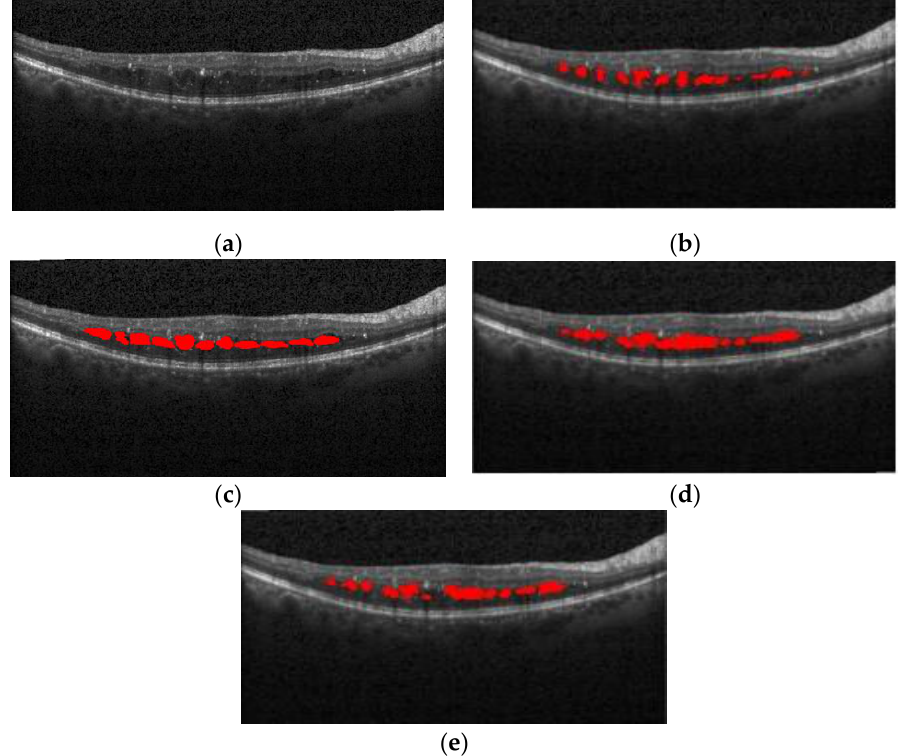
Figure 16. Figures of edema segmentation results in multi-regions with the expert 1 annotations as the ground truth: ( a ) original image; ( b ) expert 1 annotations; ( c ) expert 2 annotations; ( d ) ReLayNet predictions; ( e ) proposed method predictions.